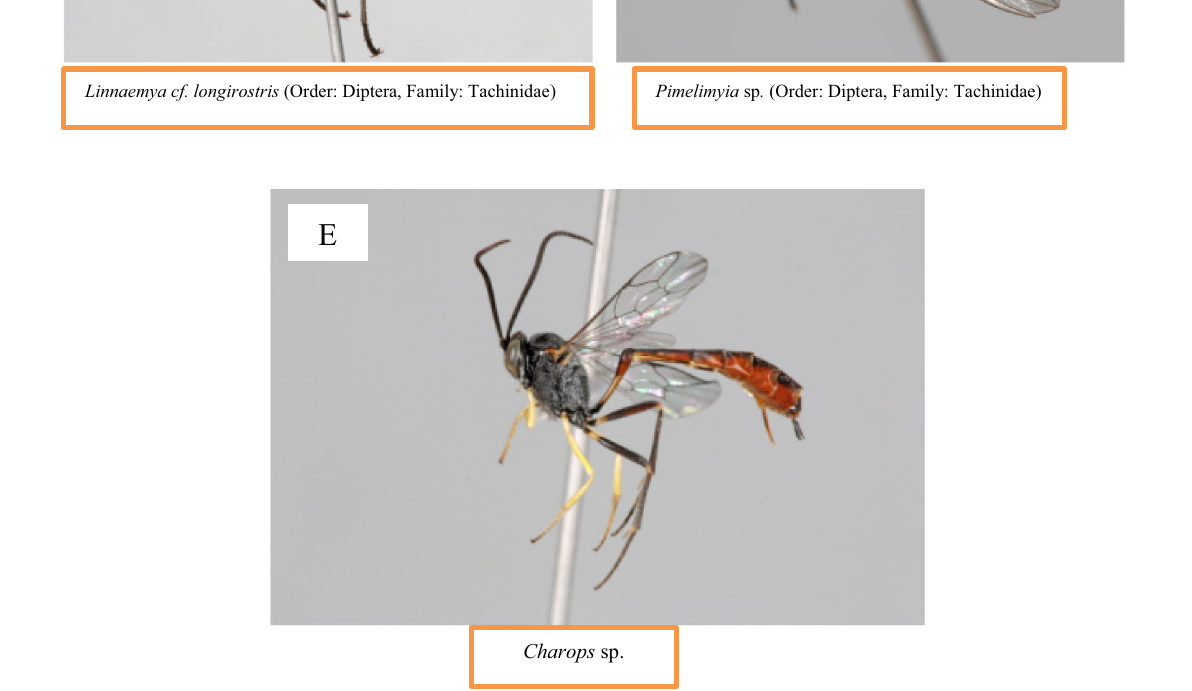
Fig. 1 Larval parasitoid of H. armigera ( Sources : Fite et al.,